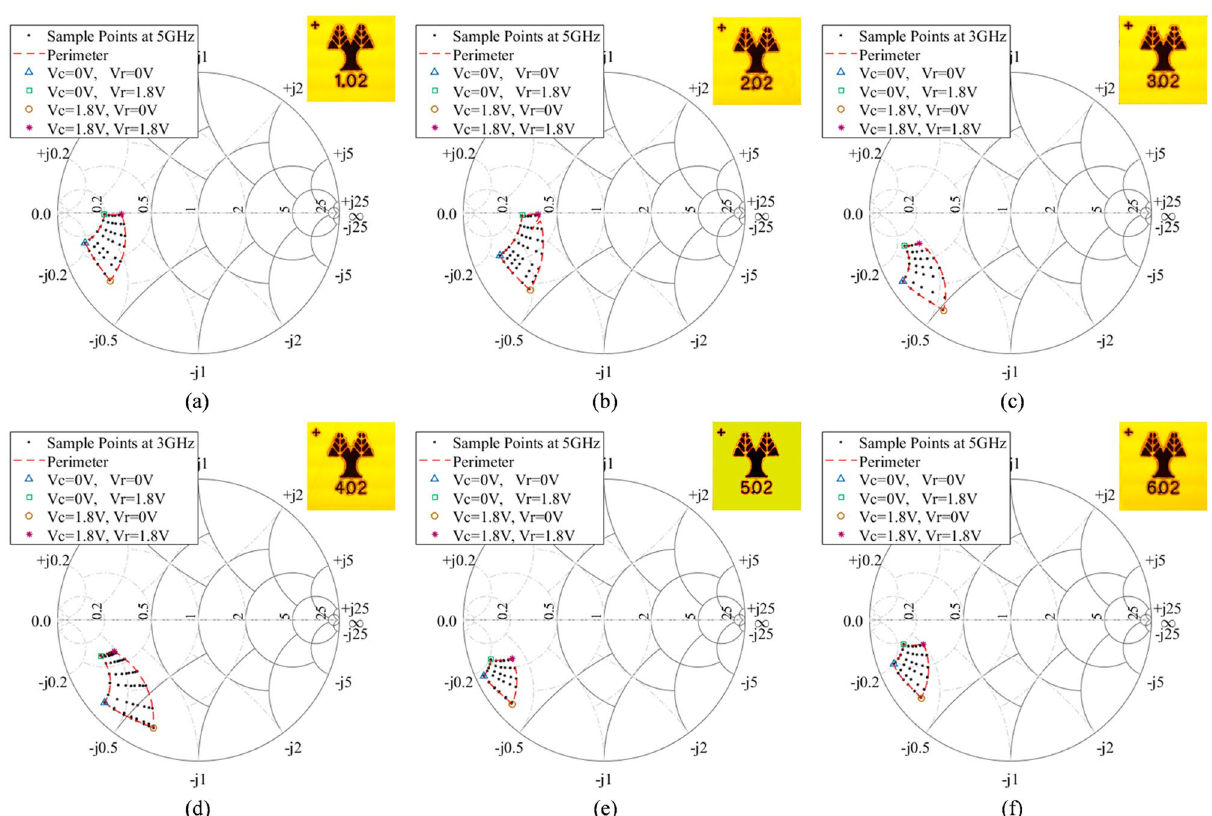
Figure 4. Smith Charts illustrating the de-embedded measured impedance responses of the loading elements for each of the six ASIC designs. The different ranges of impedances for each ASIC can be observed for bias voltages ranging from 0 < Vc < 1.8 V and 0 < Vr < 1.8 V. The red dashed line delineates the perimeter of the measured impedances at 5 GHz for all bias levels, indicating wide and varying realized impedance ranges.